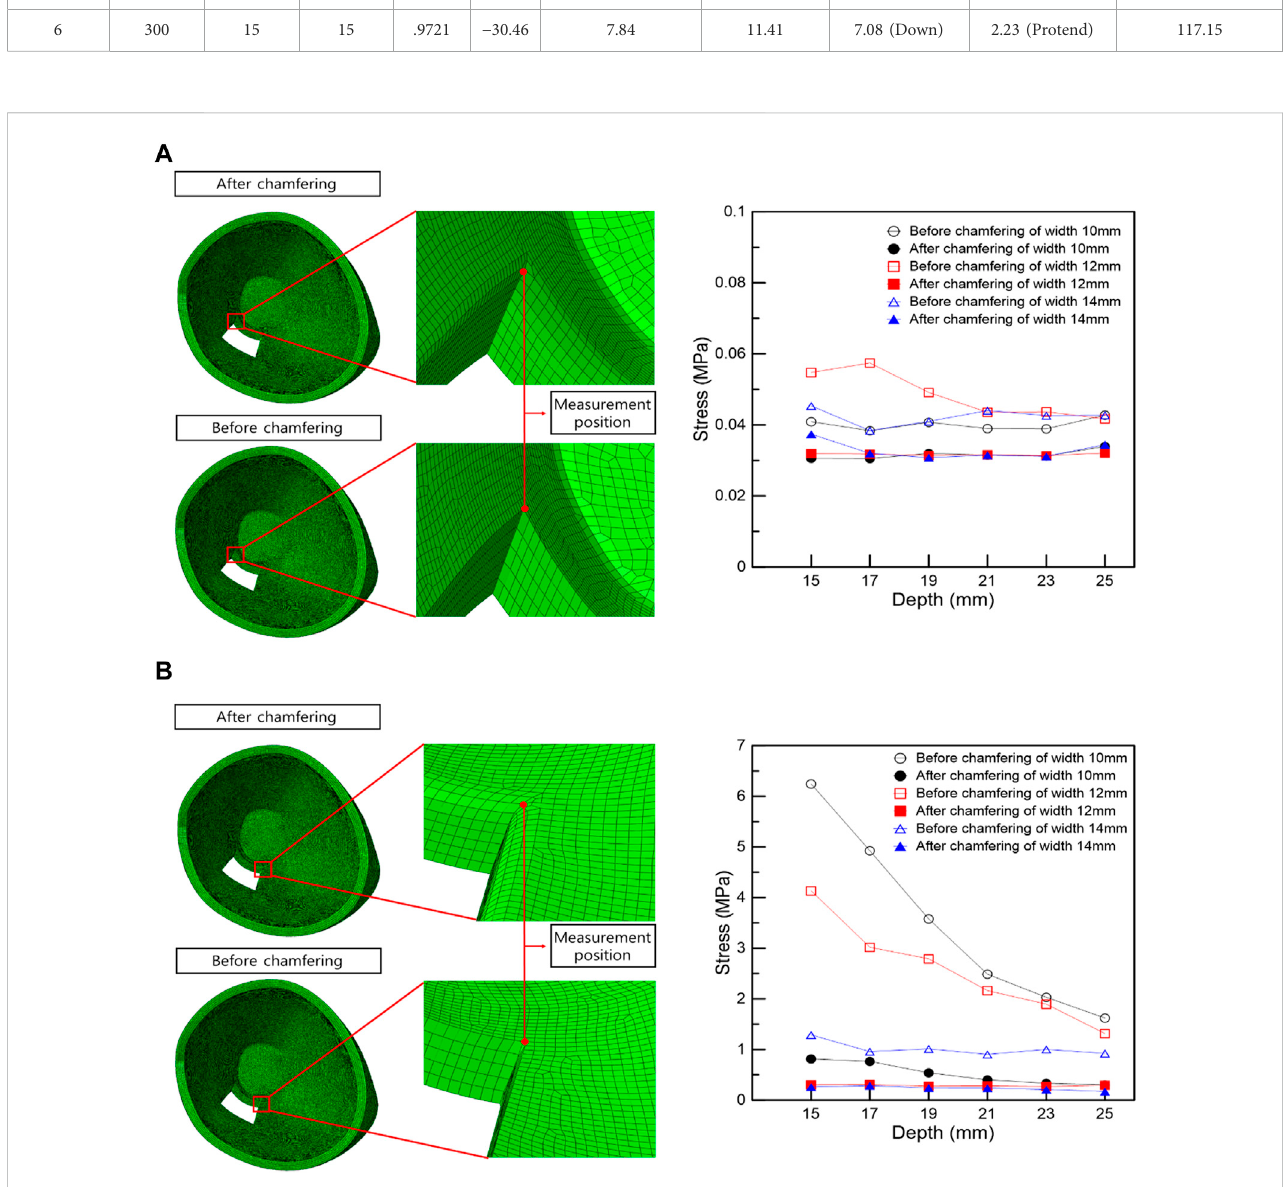
FIGURE 5 Stress measurement position and stress graph in the vertex following the rectangular removal of the orbital wall. (A) Left vertex. (B) Right vertex.